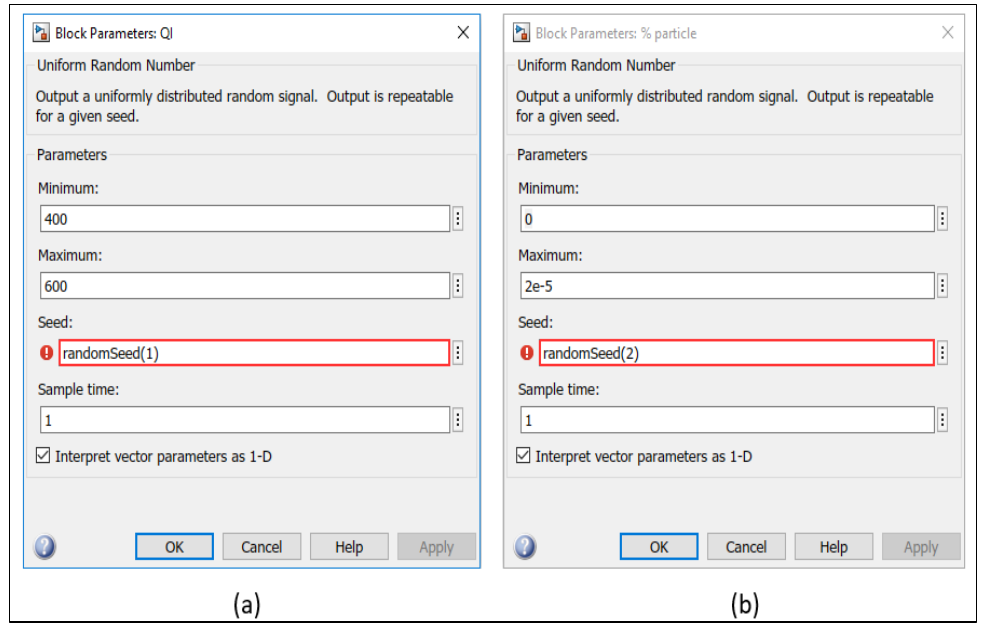
Figure A6. Block Parameters for the variables ( a ) QI and ( b ) % particle.